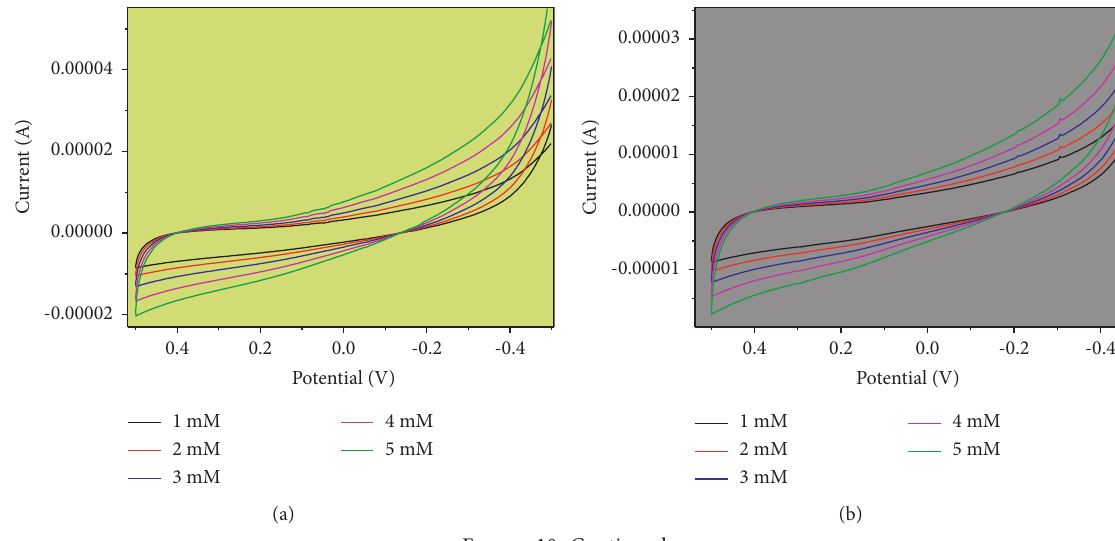
Figure 9: Amperometry response of Co 3 O 4 nanoelectrodes at various volume ratios.